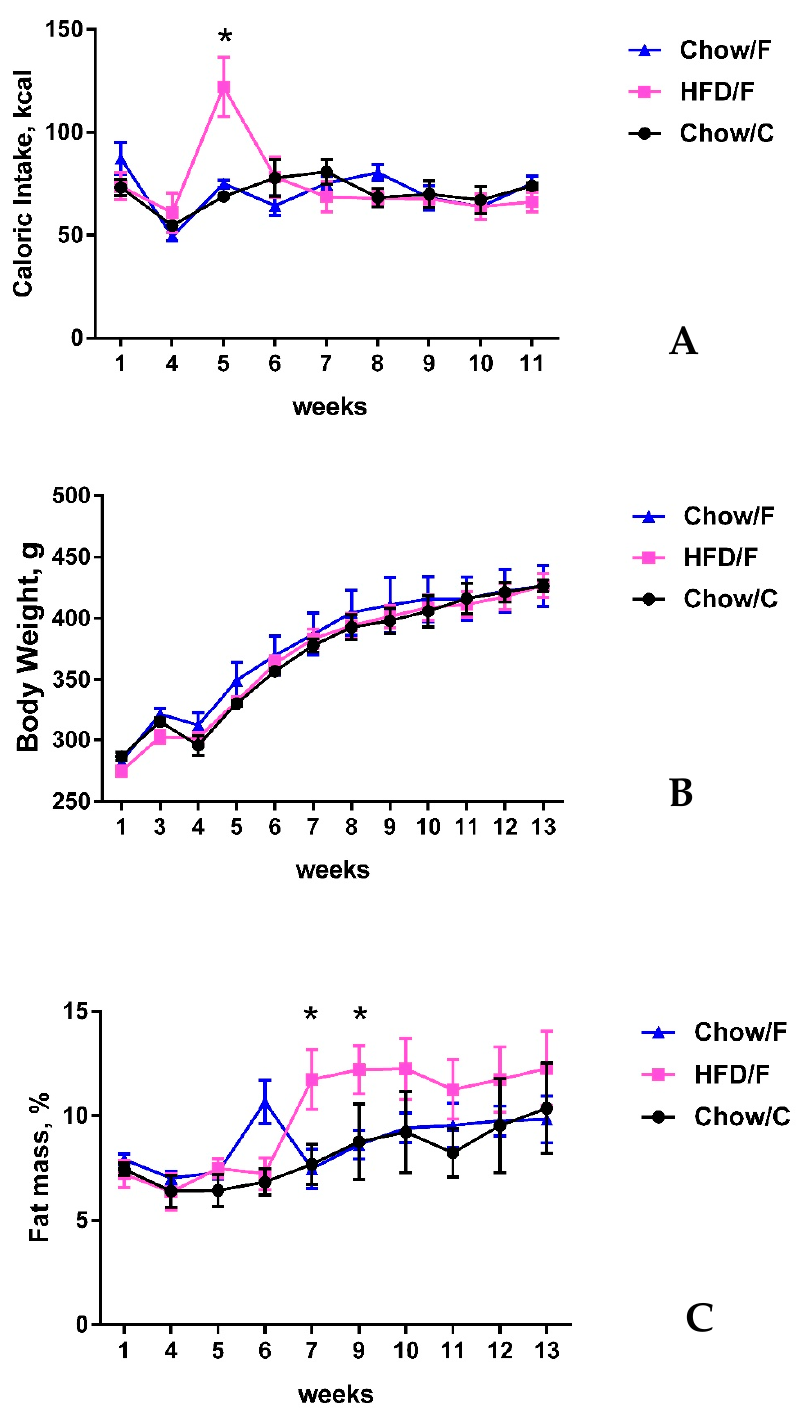
Figure 4. High-fat diet consumption increased body fat mass. Shown are mean + SD kcal consumed ( A ), body weight ( B ), and body fat mass ( C ) for rats fed a high-fat diet (HFD/F, n = 3) and rats fed regular chow (Chow/C and Chow/F, n = 3 respectively). 24-h food intake slightly decreased after fistula surgery but returned to pre-surgery level of intake within a few weeks. Animals switched to a high-fat diet significantly increased their caloric intake upon introduction of the diet, but caloric intake declined after one week and matched the intake of chow-fed animals for the duration of the study ( A ). There was no significant difference in body weight between the groups ( B ), but the high-fat fed cohort exhibited a significant increase in fat mass accumulation ( C ). * indicate statistical significance from week 1, * p < 0.05.